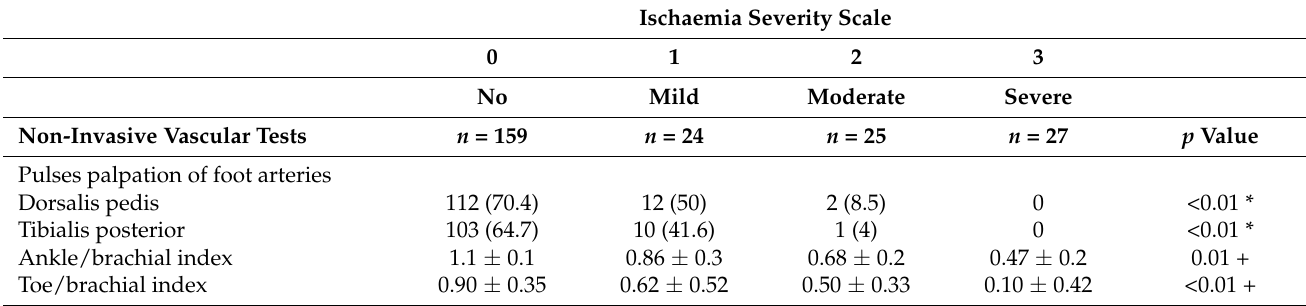
Table 2. Non-invasive vascular assessment to categorise ischaemia according to grade of severity.